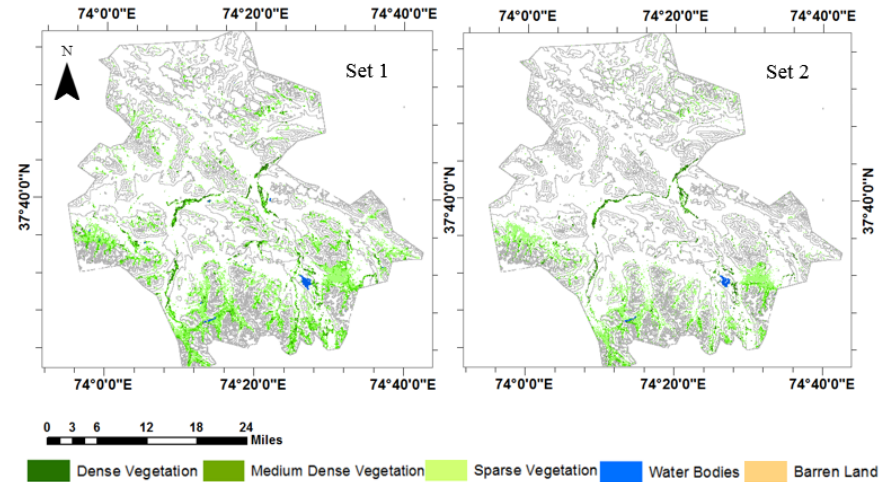
Figure 8. Map of the spatial distribution of the vegetation classes relative to the rivers/streams and the elevation layers. Note that dense vegetation is mostly found near rivers and water bodies.